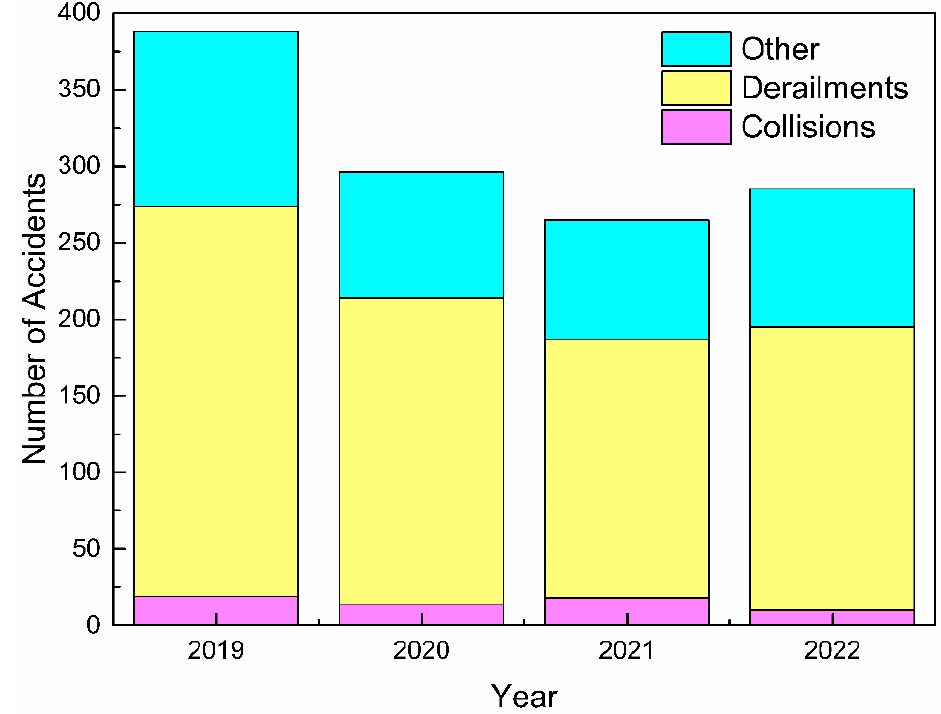
Figure 2. Main categories of railway failures in the United States from 2019 to 2022.